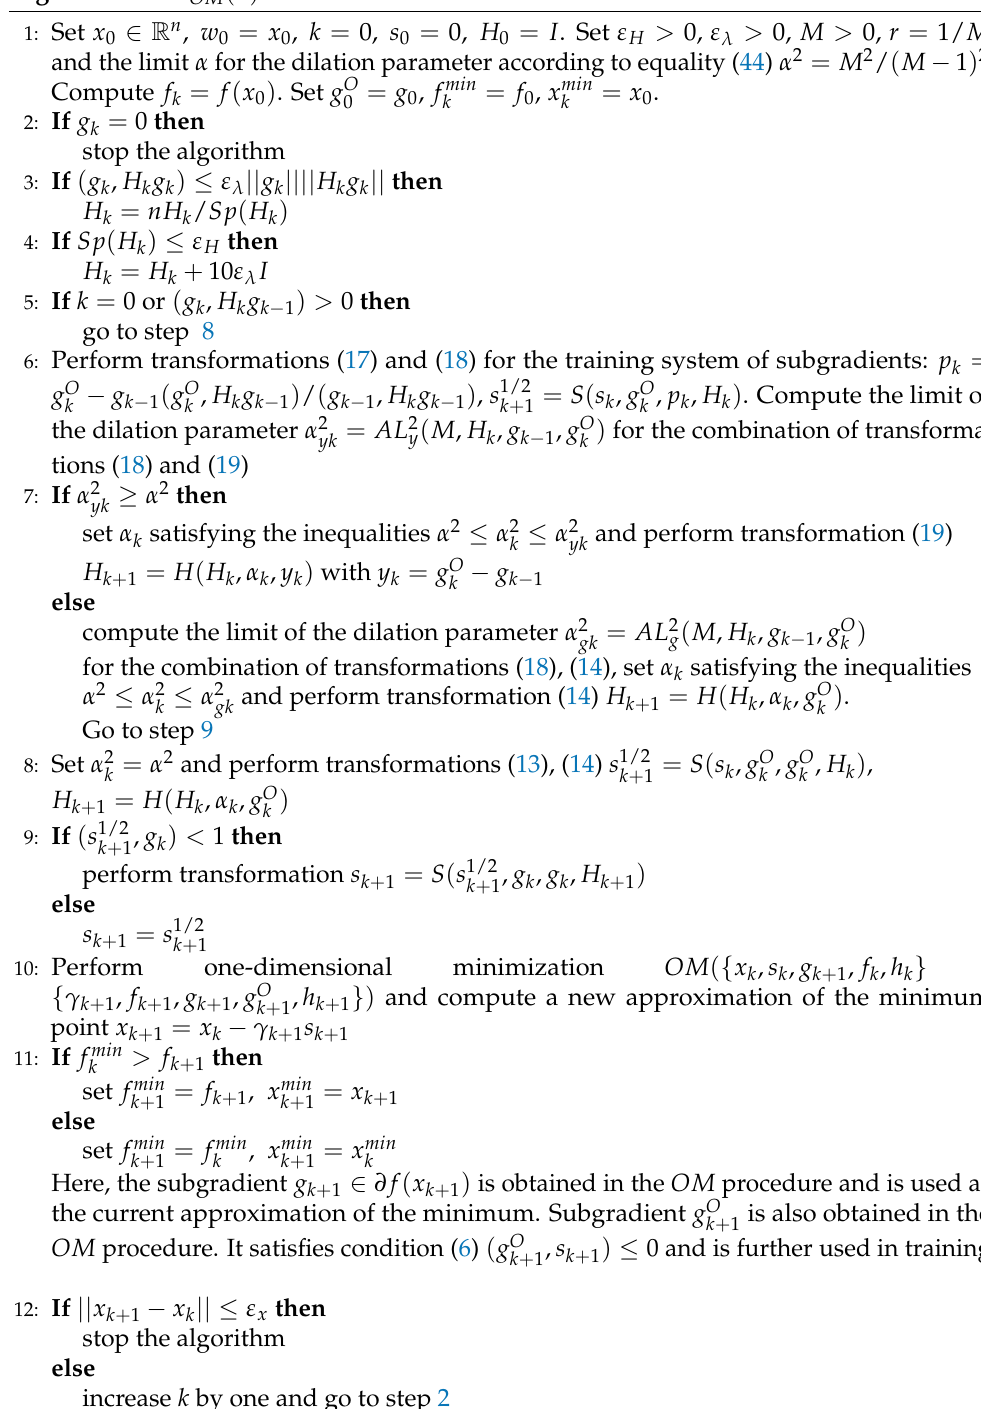
Algorithm 5 RA OM ( α